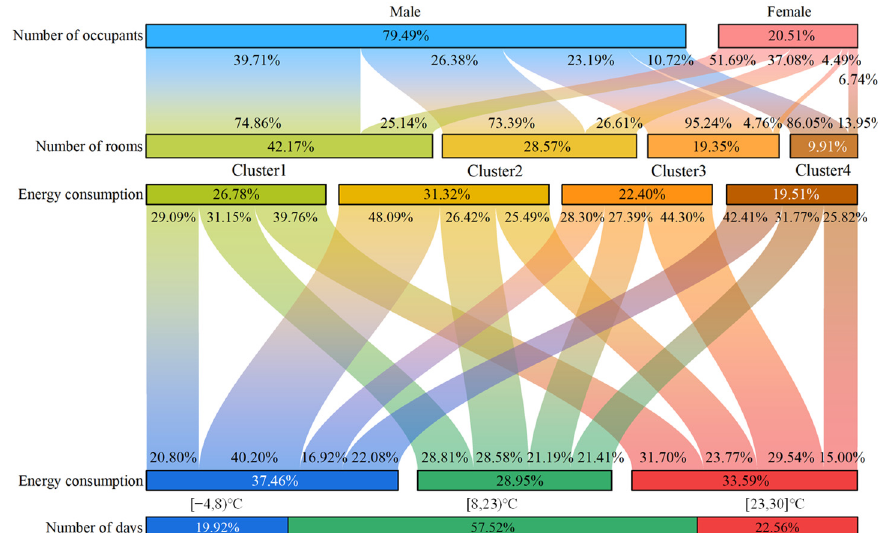
Figure 10. A composite Sankey diagram demonstrates (from top to bottom) (1) the gender proportion and its corresponding distribution in each cluster; (2) the corresponding energy consumption proportion of each cluster; (3) the cluster energy consumption distribution in each weather condition; and (4) the corresponding relation between number of days and energy consumption in each